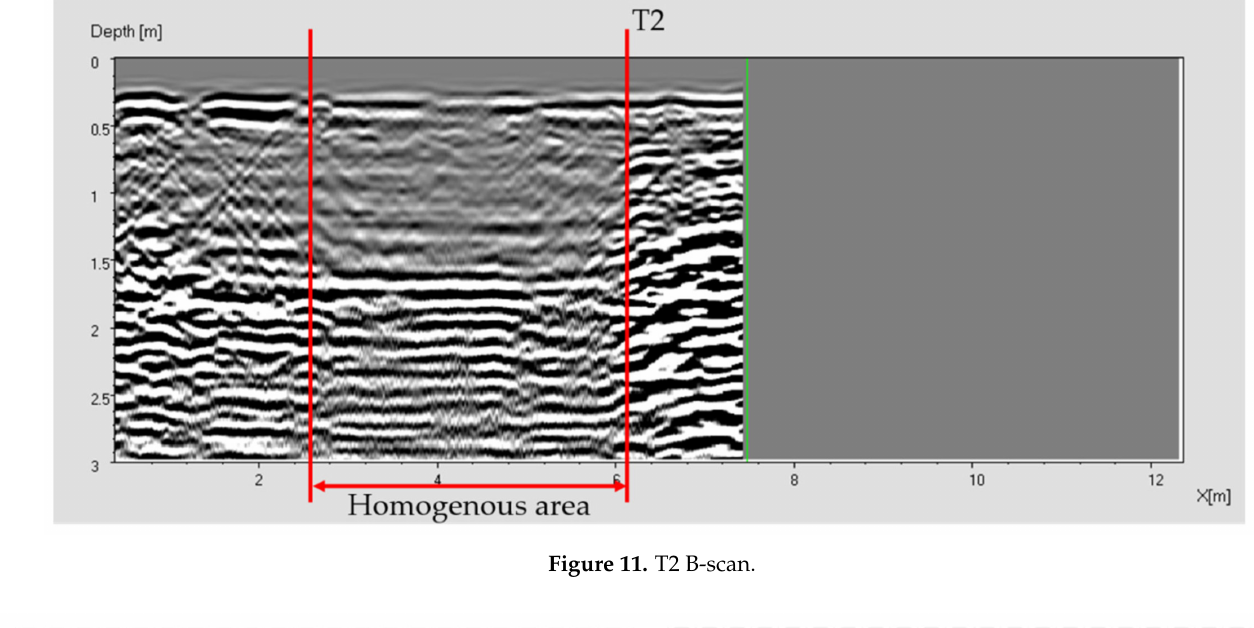
Figure 11. T2 B-scan.